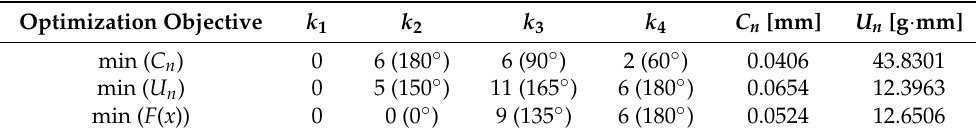
Table 3. The optimal assembly angles of the rotors at each stage and the corresponding coaxiality and unbalance of the high-pressure rotor